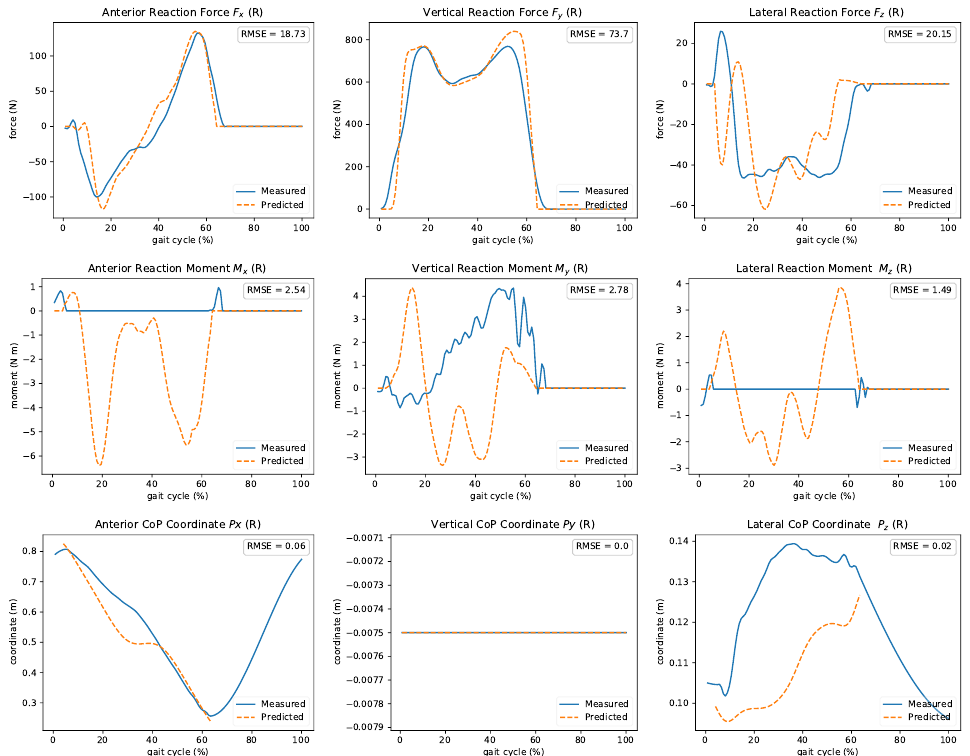
Figure 9. Real-time estimated ground reaction forces, moments, and CoP during gait. Good agree- ment of the predicted forces, especially on the forward ( x ) and vertical ( y ) directions. In contrast, only the x component of the CoP was accurately predicted. Less confluence is observed in the